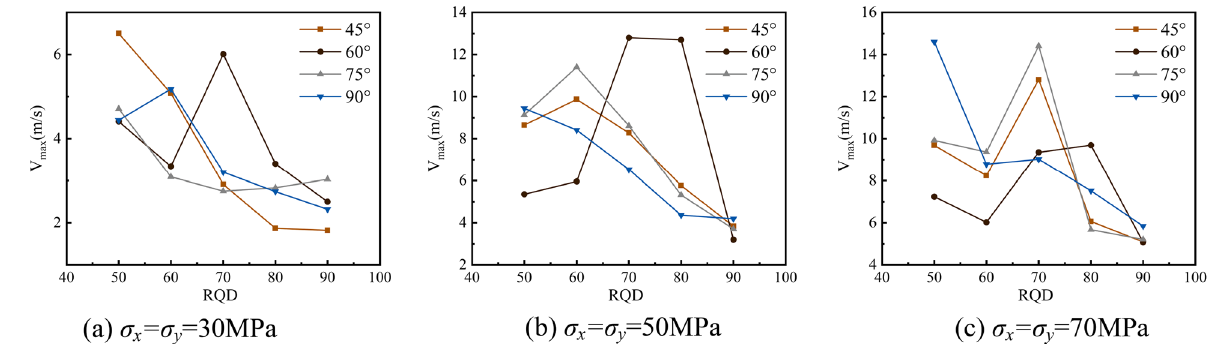
Fig. 17 V max with different values of